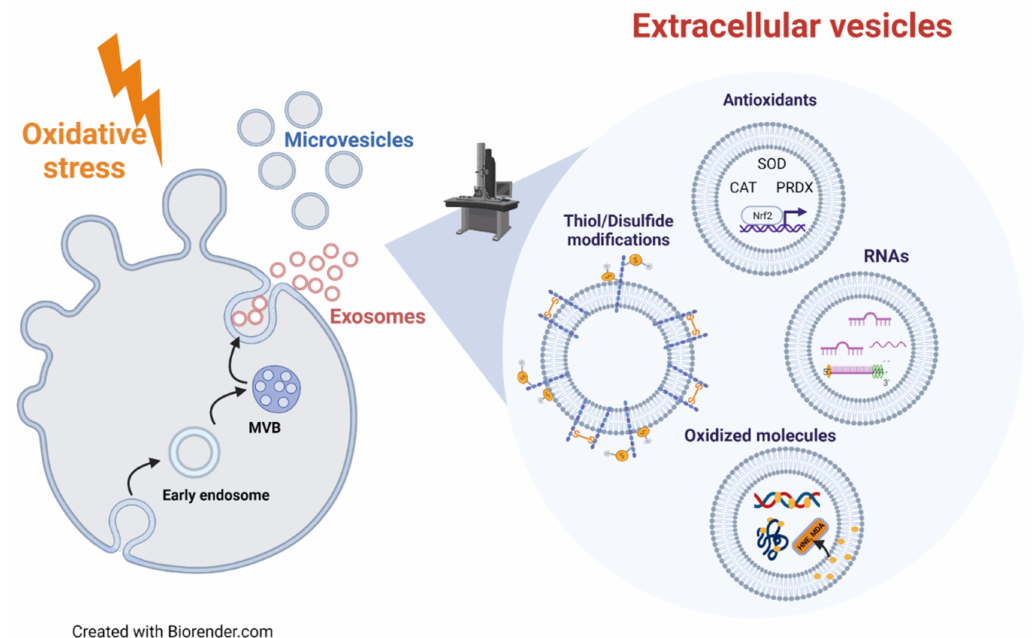
Figure 2. Link between EVs and redox status of originating cells. Oxidative stress conditions influence the release and the molecular cargo of EVs, both exosomes and microvesicles, which can modulate the redox status of target cells. Oxidative stress-related EVs can carry components of antioxidant machinery (SOD, CAT, PRDX and Nrf2), oxidized molecules, specific RNAs involved in cell response to oxidative stress and an altered content of protein thiol/disulfide groups. The delivery of these molecules via EVs could be a way used by oxidatively stressed cells to eliminate damaged/toxic molecules. In addition, the oxidative stress-related molecular cargo of EVs can be transferred to target cells, thus modulating their response to oxidative